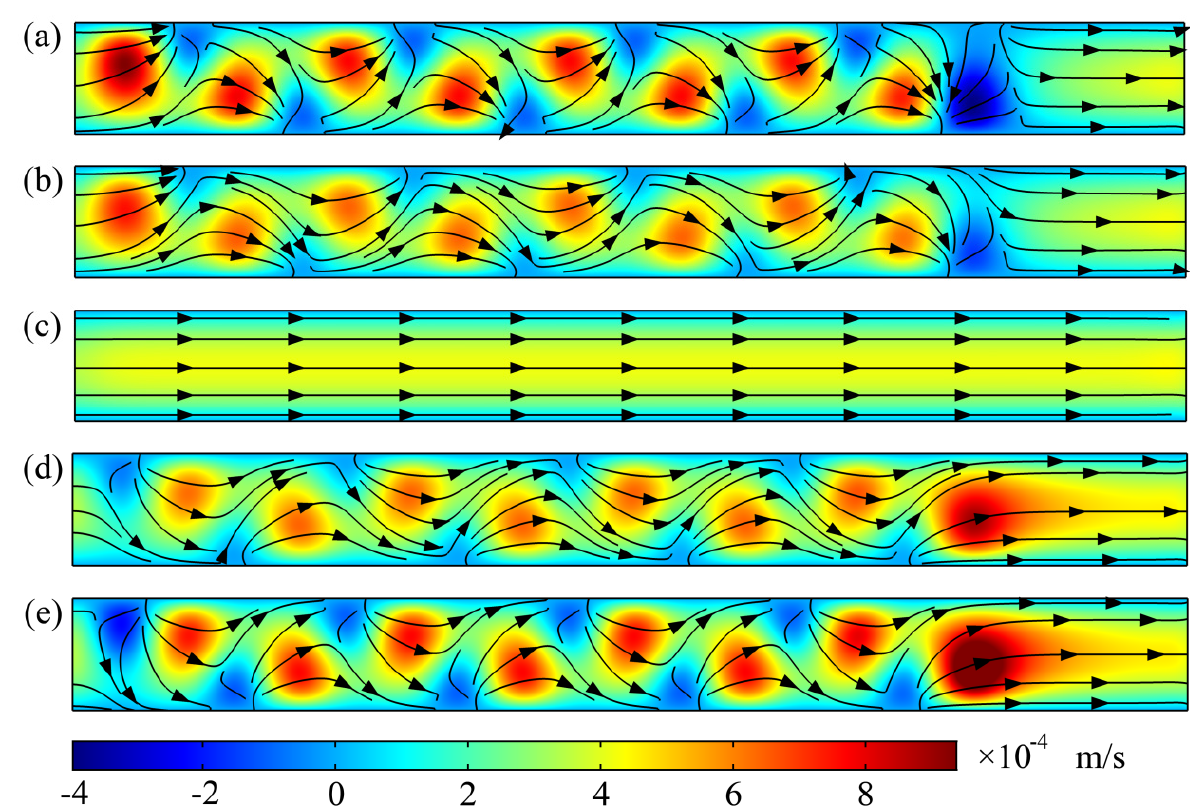
Figure 4. Flow fields of D–D section in the microchannel at five different moments during one cycle: ( a ) t = 1/4 T, ( b ) t = 3/8 T, ( c ) t = 1/2 T, ( d ) t = 5/8 T and ( e ) t = 3/4 T. Peak-to-peak value of applied potential was V 0 = 1 V, electric-field frequency was f = 5 Hz, and inlet mean velocity was U m = 2 × 10 –4 m/s. Length was L o = 10 µ m, width was W o = 10 µ m, and spacing was S o = 10 µ m of the virtual electrode. Aspect ratio of the microchannel was W c / H c = 1. Black lines, streamlines; black arrows, flow direction; color legend, magnitude of the velocity component in the x